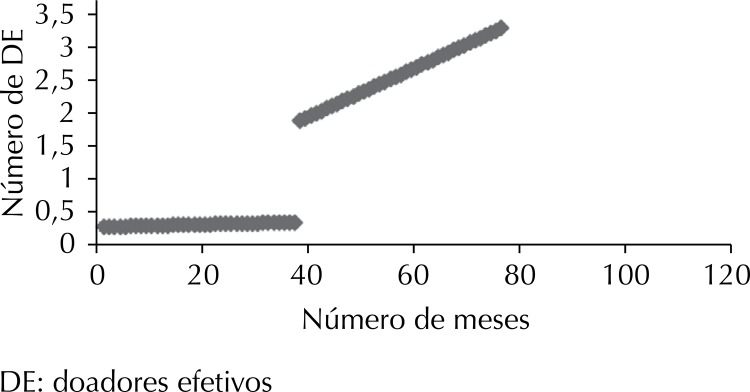
Número de doadores efetivos antes e depois do projeto no Hospital 2. São Paulo, 2005 a 2011.